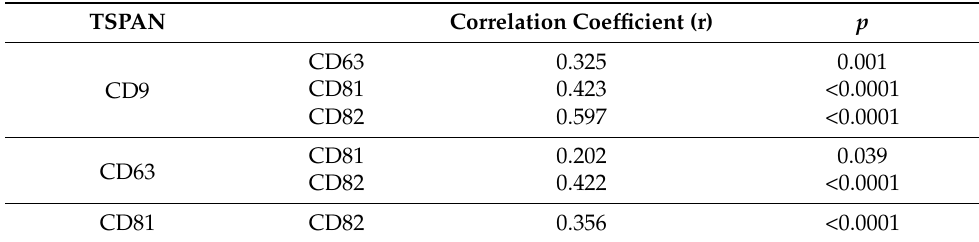
Table 3. Correlation analysis of